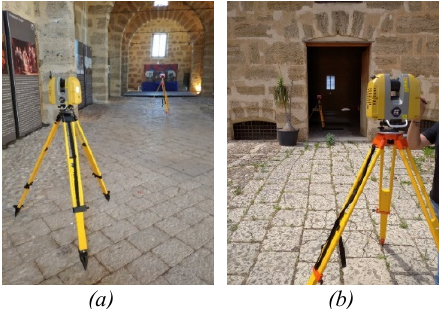
Figure 6 . Laser scanner survey: inside ( a ) and outside acquisitions ( b ).